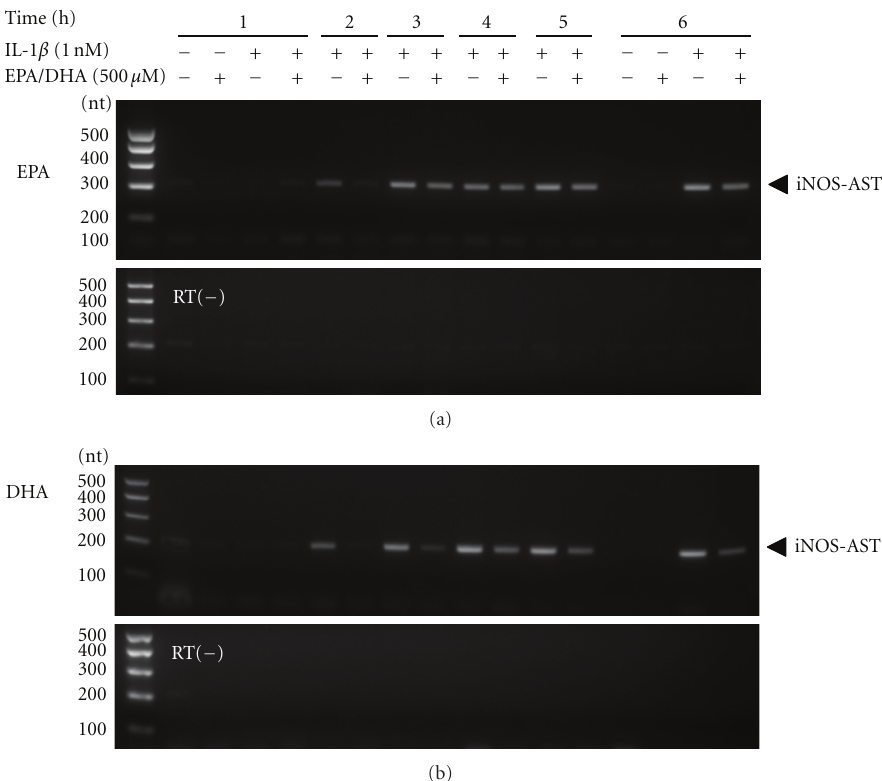
Figure 11: E ff ects of peroxidized EPA/DHA on the expression of the iNOS gene antisense transcript. Cells were treated with IL-1 β (1nM) in the presence or absence of peroxidized EPA for 3 days (a) and DHA for 1.5 days (b) (each, 500 μ M) for the indicated times. Total RNA was analyzed by strand-specific RT-PCR to detect the iNOS gene antisense transcript (iNOS-AST). RT( − ): a negative control PCR using total RNA without